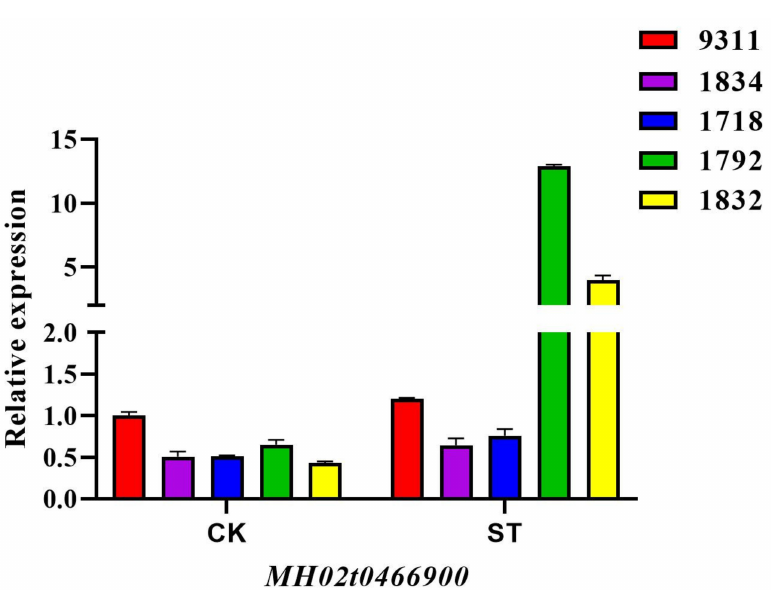
Figure 5. qPCR analysis of the expression of candidate gene MH02t0466900 in seedlings under salt stress. The BIL lines of B1792 and B1832 contained qSIS2/qWCSST2/qRWCS2 locus, while the 1834 and 1718 did not contain the